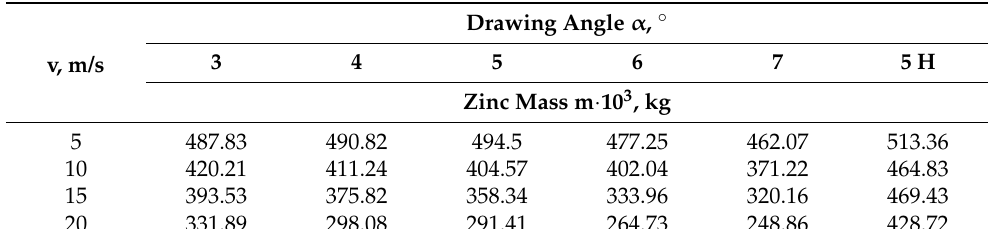
Table 5. Total mass of zinc per 100,000 tons of 2.2 mm wire, depending on the drawing technology used, where α —drawing angle, H—hydrodynamic dies, v—drawing speed.